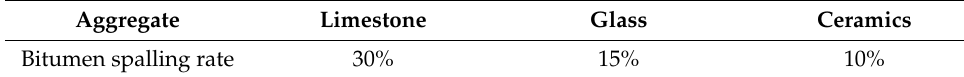
Table 13. Bitumen spalling rate during the water boiling process. Aggregate Limestone Glass Ceramics Bitumen spalling rate 30% 15%